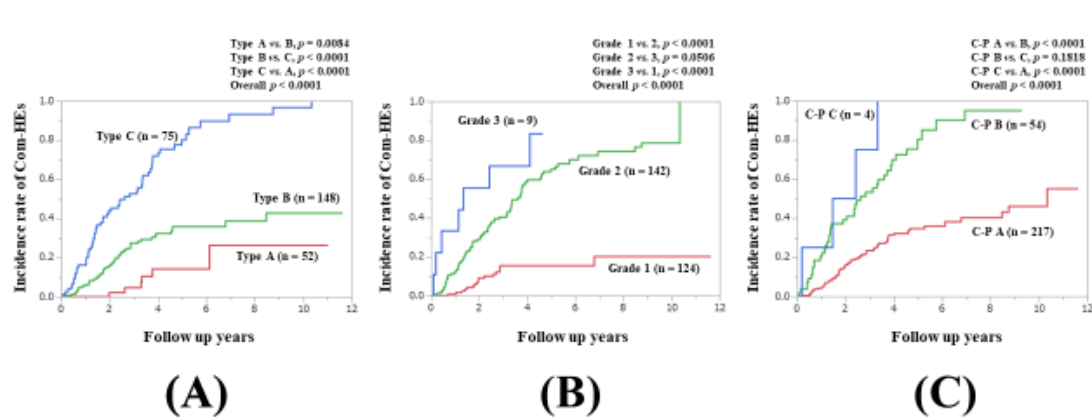
Figure 1. Cumulative incidence rates of composite hepatic events for all cases (n = 275). ( A ) Serum Zn level grading system. ( B ) ALBI grading system. ( C ) Child–Pugh classification.